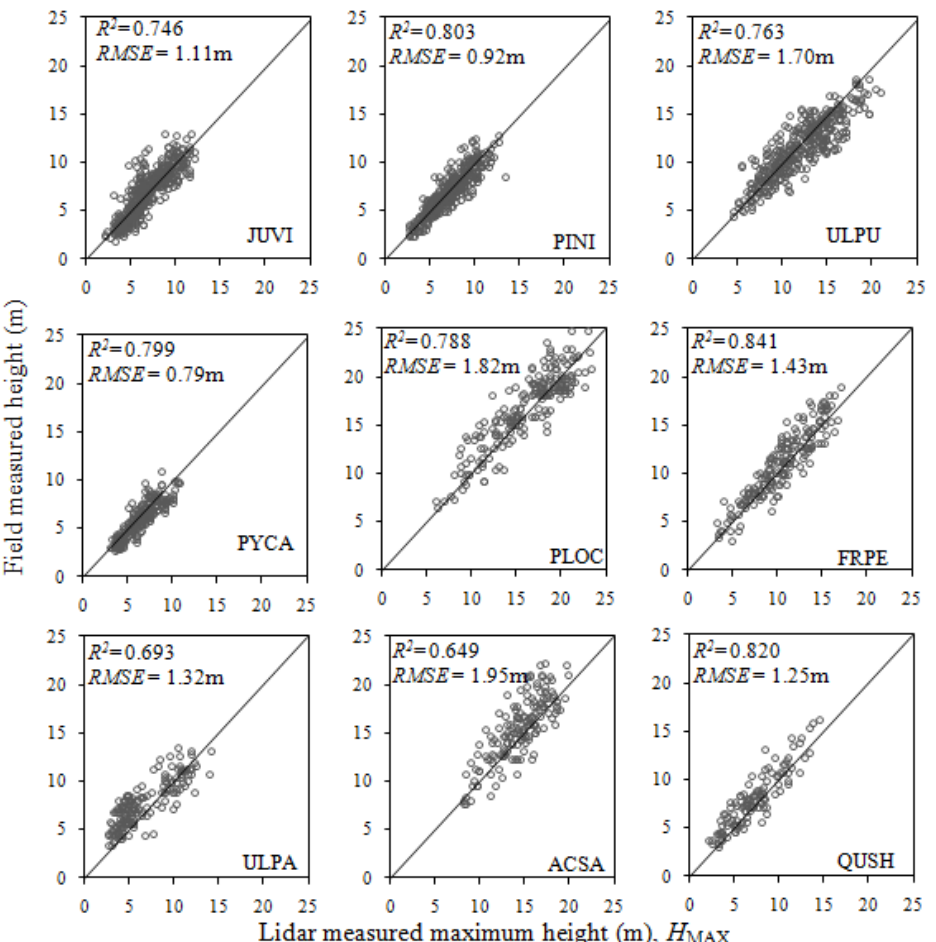
Figure 5. Relationship between field-measured height and lidar-measured maximum height in major species of the study area. Tree species abbreviations: JUVI = Juniperus virginiana , PINI = Pinus nigra , ULPU = Ulmus pumila , PYCA = Pyrus calleryana , PLOC = Platanus occidentalis , FRPE = Fraxinus pennsylvanica , ULPA = Ulmus parviflora , ACSA = Acer saccharinum , QUSH = Quercus